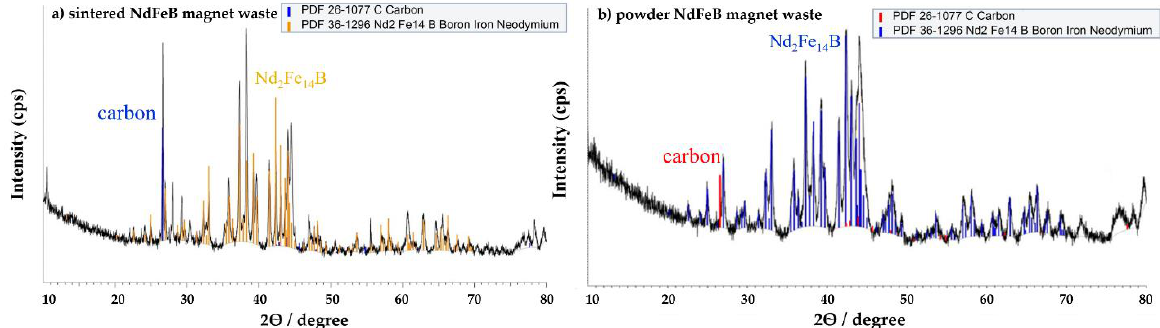
Figure 2. XRD patterns of manufacturing NdFeB magnet wastes in the as-received condition from ( a ) sintering and ( b ) powder fabrication processes. ( a ) sintering and ( b ) powder fabrication